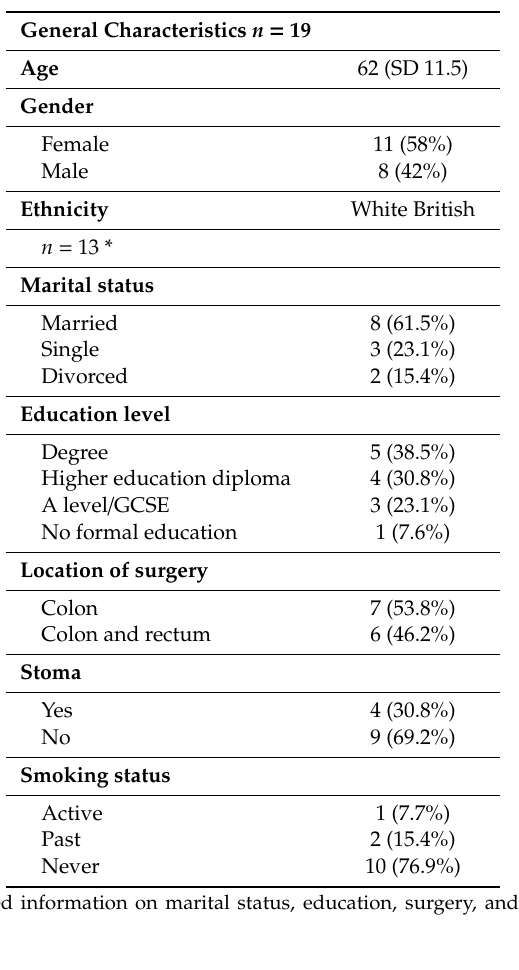
Table 1. Characteristics of survivors of CRC.